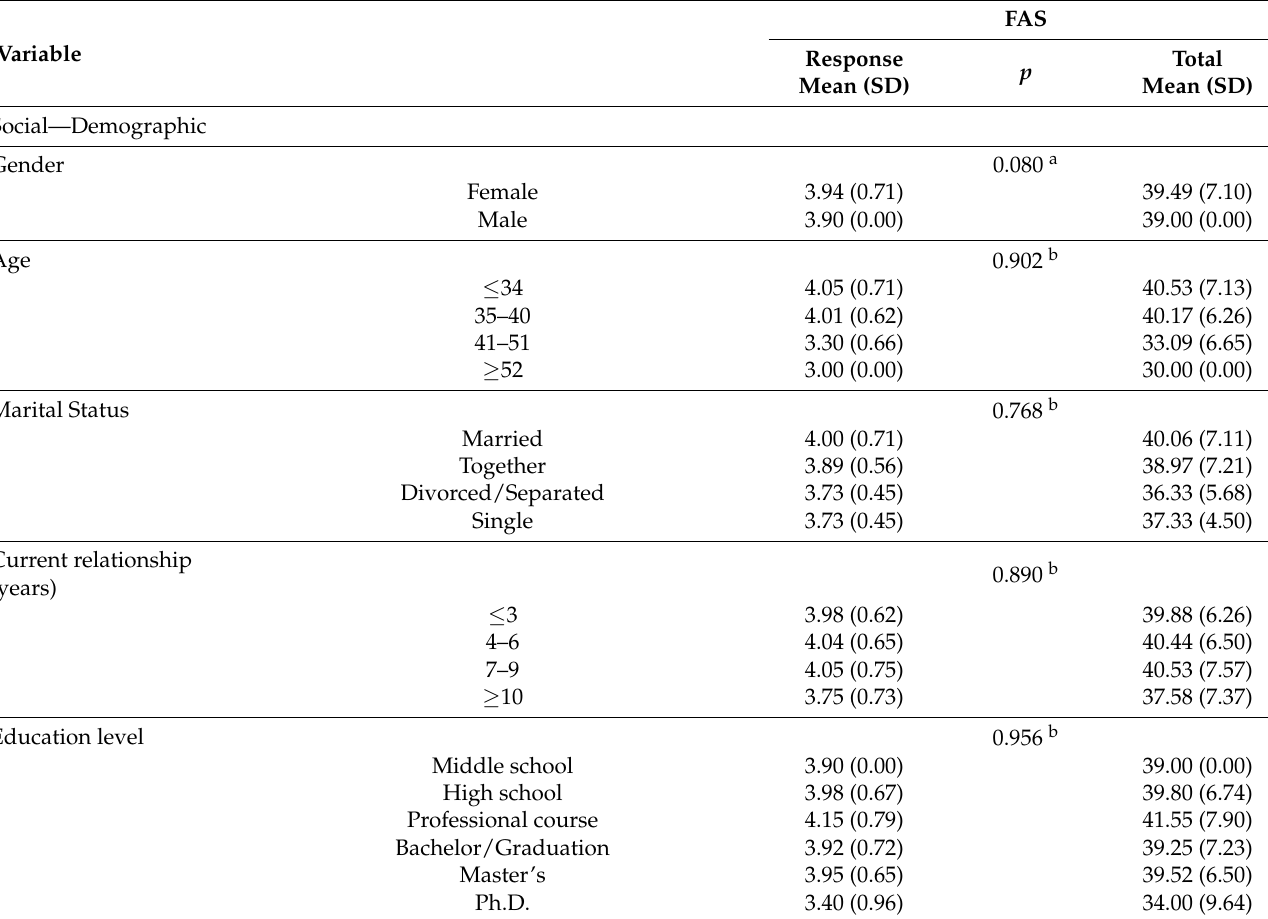
Table 1. Mean scores of the FAS regarding characteristics of participants ( n =